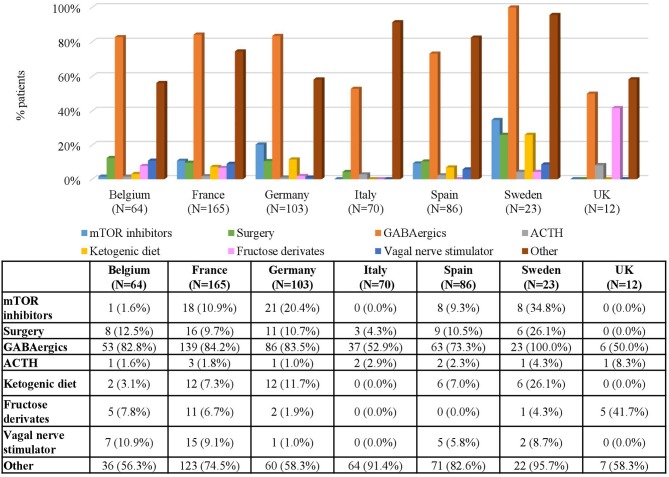
Treatments for Focal Seizures by Country. Patients may receive more than one treatment.